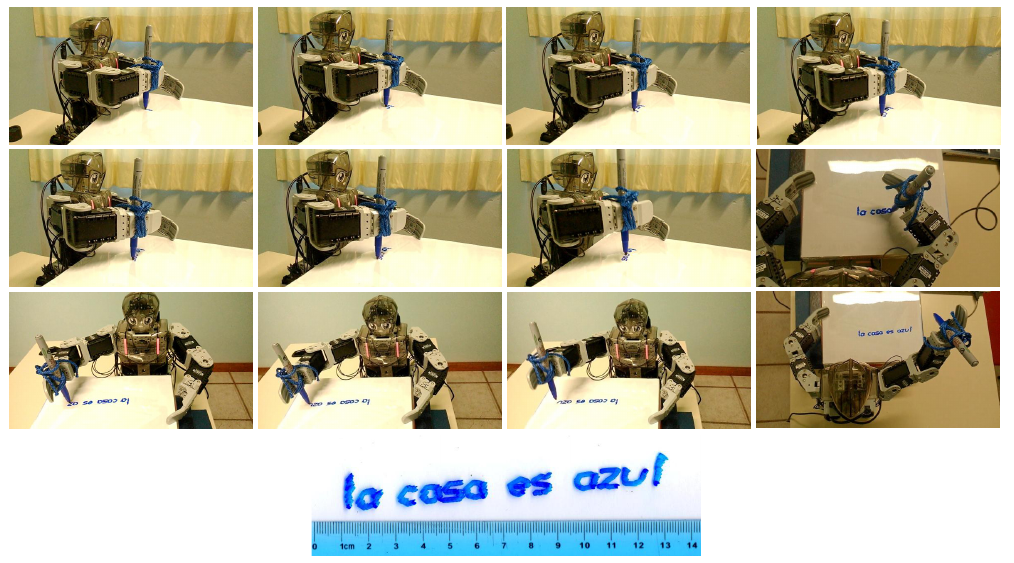
Figure 14. Transcription of a short sentence with the Bioloid’s right arm and the kinematics models ( r = 0.3 cm).